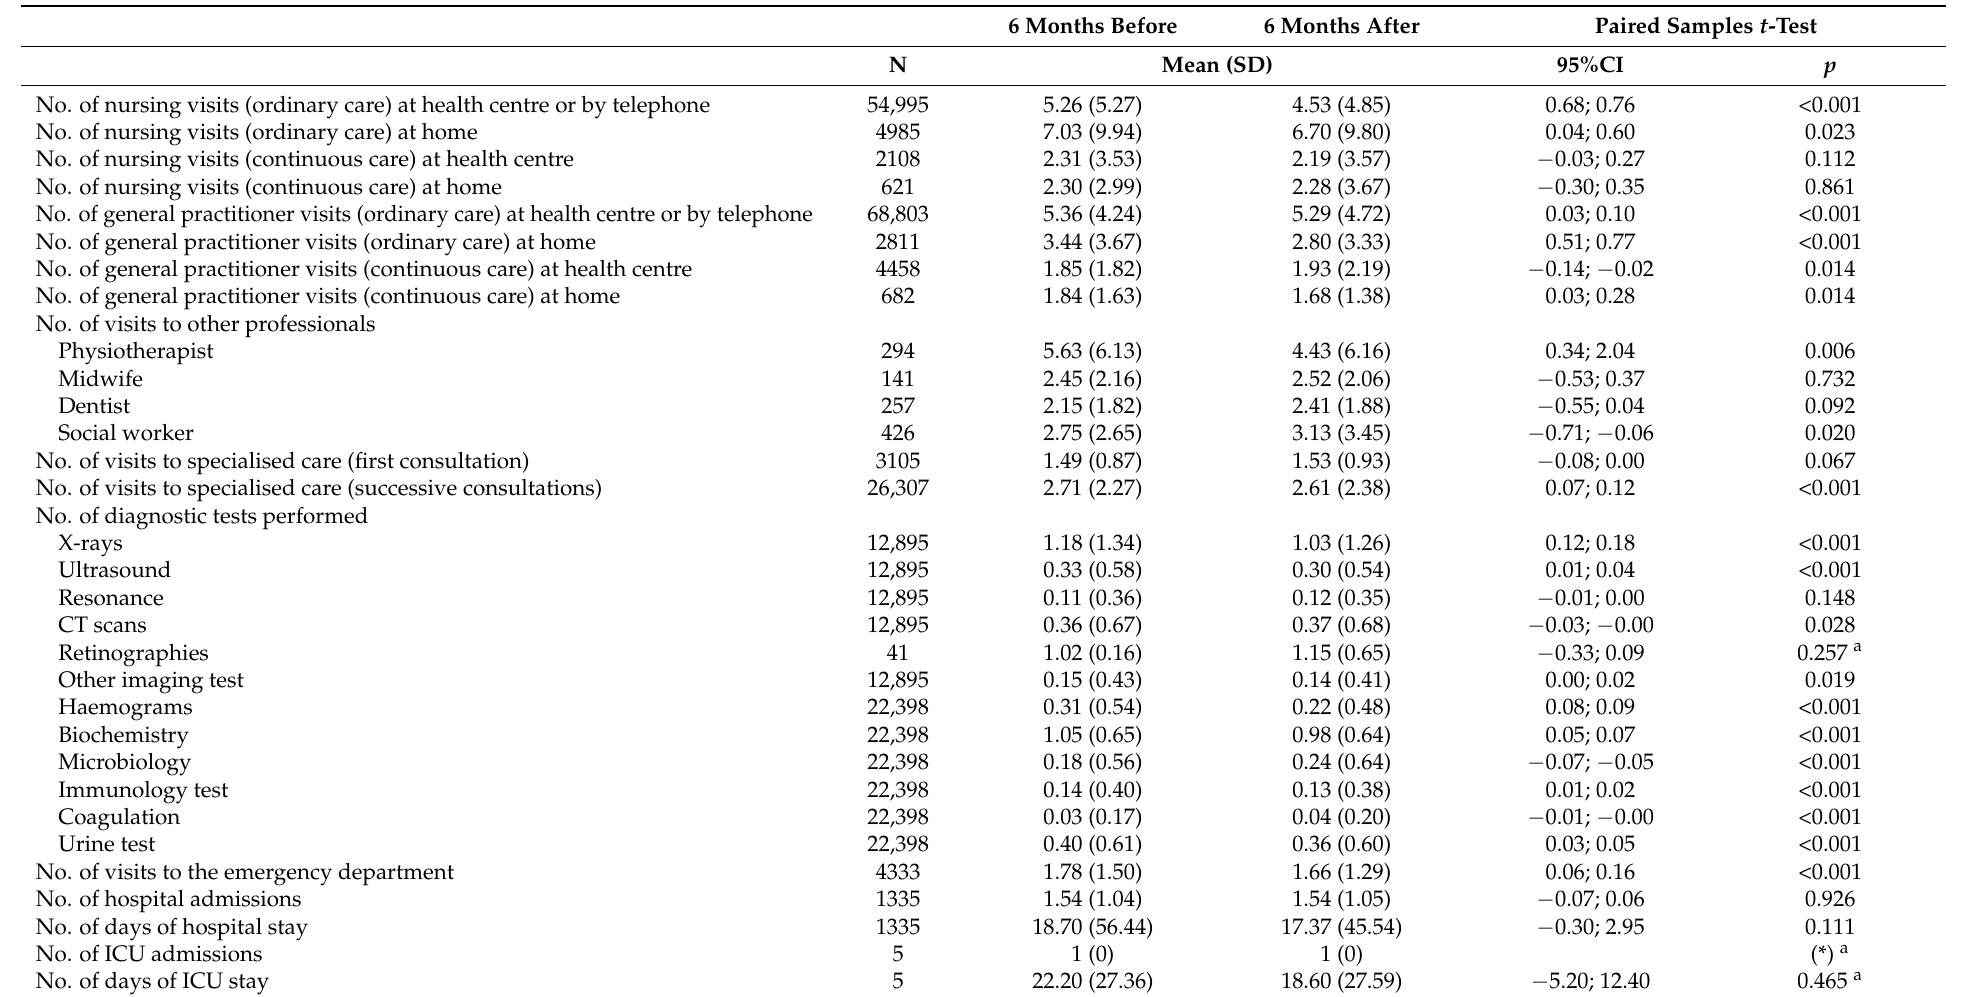
Table 5. Number of visits and diagnostic tests prescribed 6 months before and 6 months after